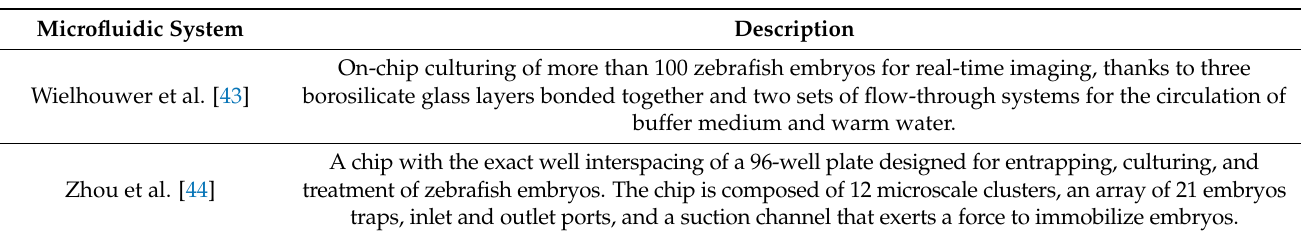
Table 2. Examples of flow-through-based microfluidic systems for raising of embryonic and larval